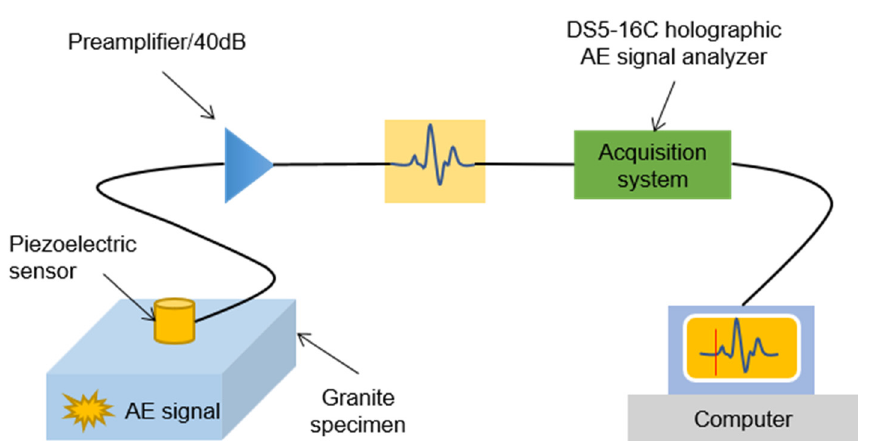
Figure 4. Acquisition process of the AE signal generated by pencil lead breaks.